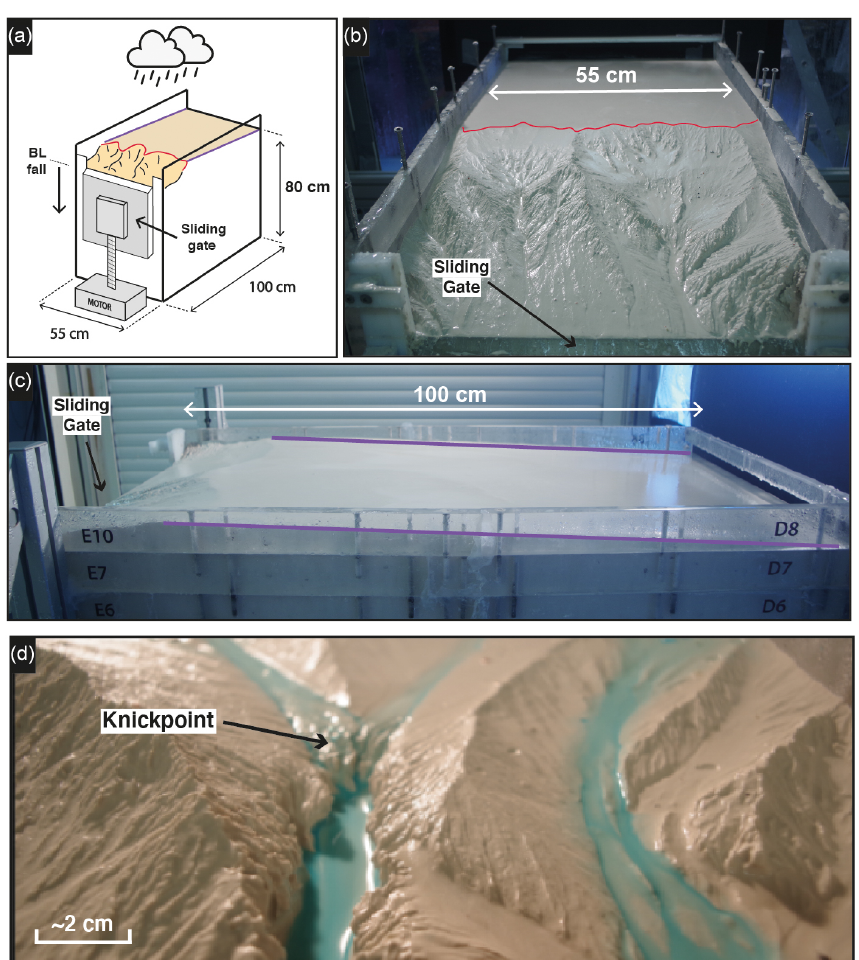
Figure 1. Experimental setup. Purple and red lines show, respectively, the counterslope of the initial topography and the main water divide. (a) Sketch of the erosion box with the sliding gate, 41cm wide, used to drop down the base level (BL). (b, c) Front and side photographs (experiments BL10 at 525min and BL15 at 185min). (d) Photograph of a typical knickpoint studied here.